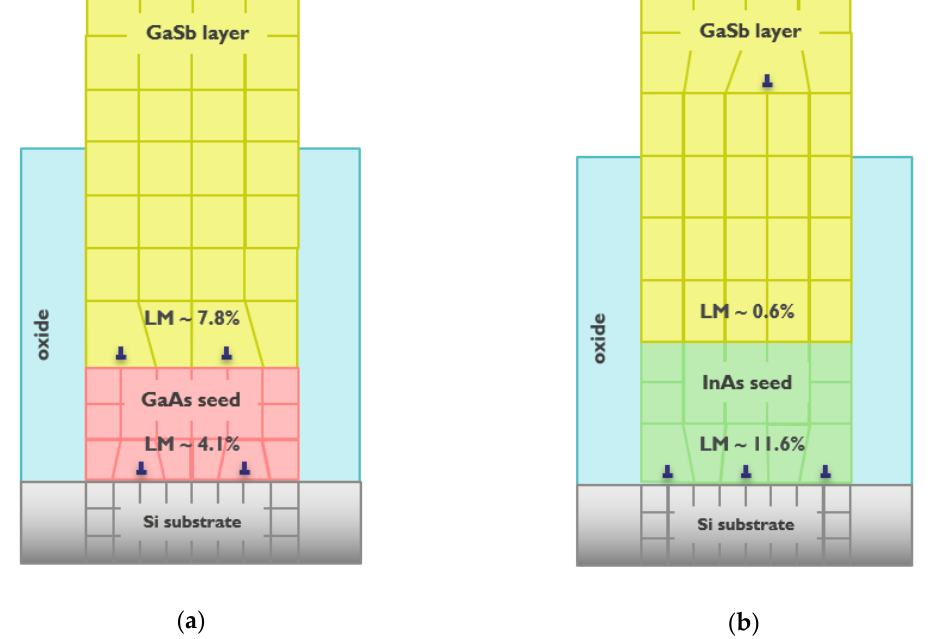
Figure 8. Layer sketch illustrating the various lattice mismatches (LM) towards the underlying layer for the GaSb integration on a GaAs ( a ) and InAs ( b ) seed. for the GaSb integration on a GaAs ( a ) and InAs ( b )